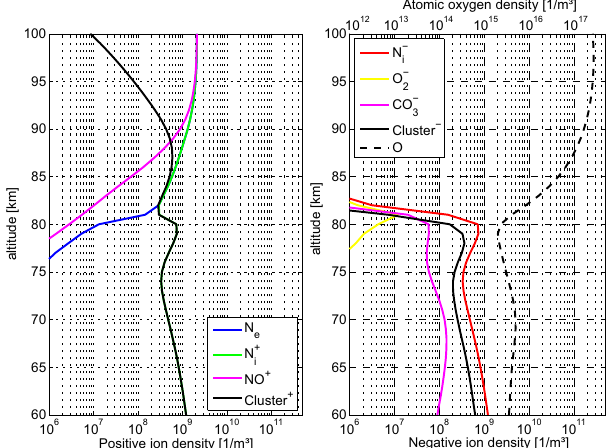
Fig. 3. Density profiles of selected positive ions and electrons (left) and density profiles of negative ions together with the atomic oxy- gen profile (right); Cluster + / − means the sum of all cluster ions, + / − N denotes the sum of all ions, for 8th September 2010, 23:55 i LT, 69 ◦ N, 16 ◦